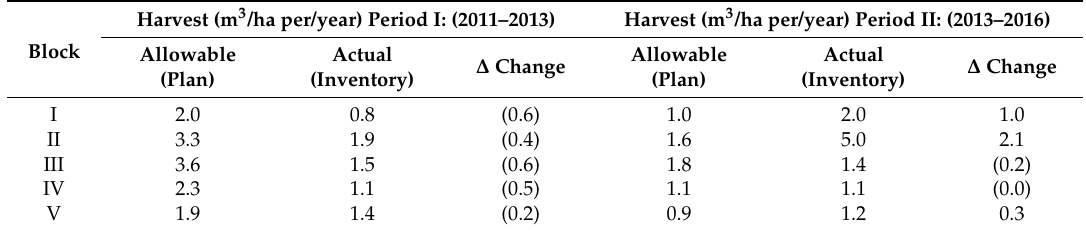
Table 4. Block wise allowable harvest in FMP and actual harvest from inventory.